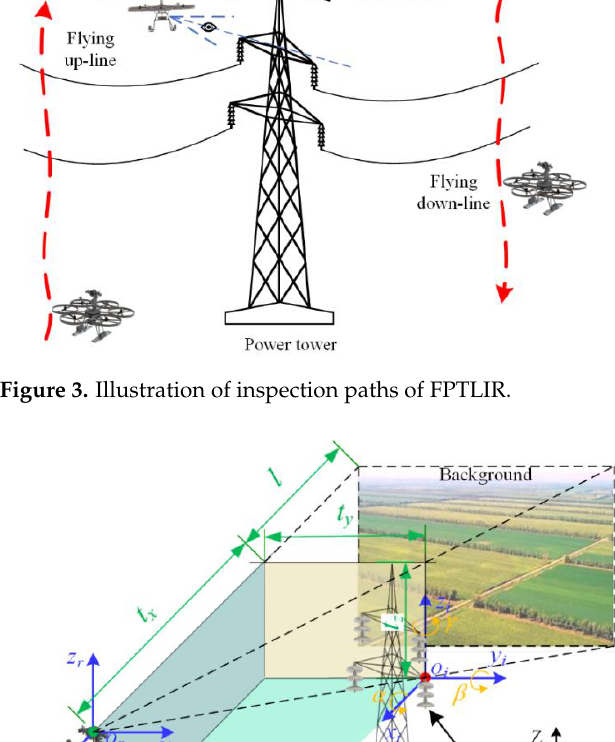
Figure 3. Illustration of inspection paths of FPTLIR.